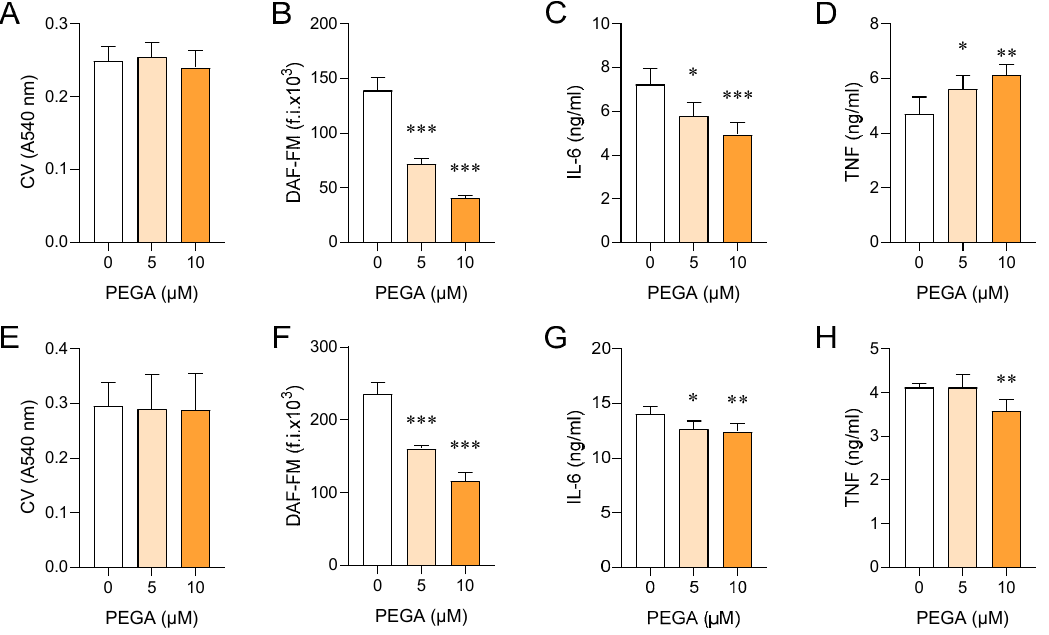
Figure 3. Effects of PEGA on macrophages and microglial cells. Lipopolysaccharide (LPS)-stimulated PM ( A – D ) or IFN- γ + LPS-stimulated BV2 cells ( E – H ) were untreated (0) or treated for 20 h with PEGA. Viability was determined by the crystal violet (CV) test ( A , E ), NO production was assessed by DAF-FM staining ( B , F ), IL-6 ( C , G ) and TNF ( D , H ) levels were determined in cell culture supernatants by ELISA. Data are presented as mean + SD obtained in 4 ( A – D ), 8 ( E ), 6 ( F ), or 5 ( G , H ) independent experiments. One-way ANOVA followed by Tukey’s multiple comparison test, * p < 0.05, ** p < 0.01, *** p < 0.001, 0 vs. PEGA.